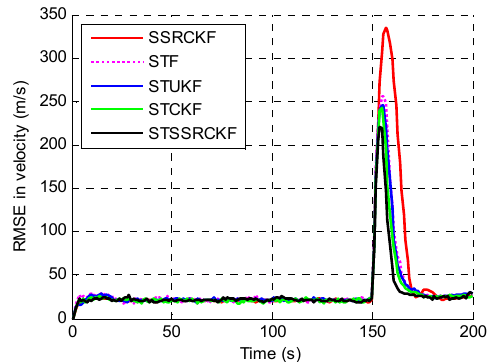
Figure 1. Root mean square error (RMSE) of the estimated position.